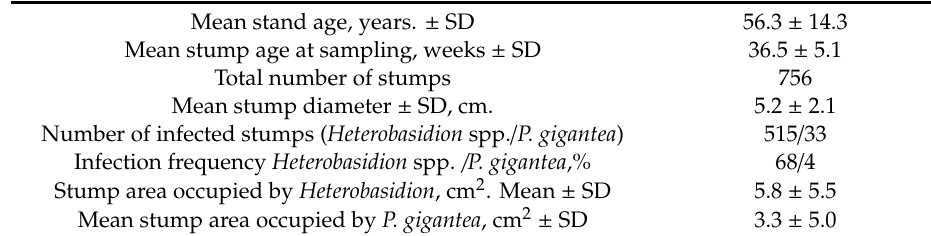
Table 2. Characteristics of sampled understory Norway spruce stumps and average infection frequency of Heterobasidion spp. and Phlebiopsis gigantea.